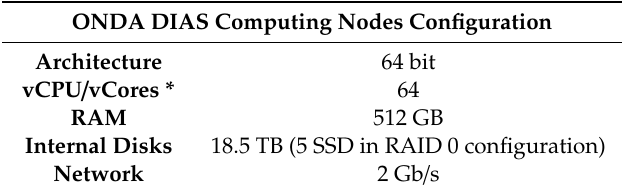
Table 1. ONDA DIAS Computing Nodes Configuration.